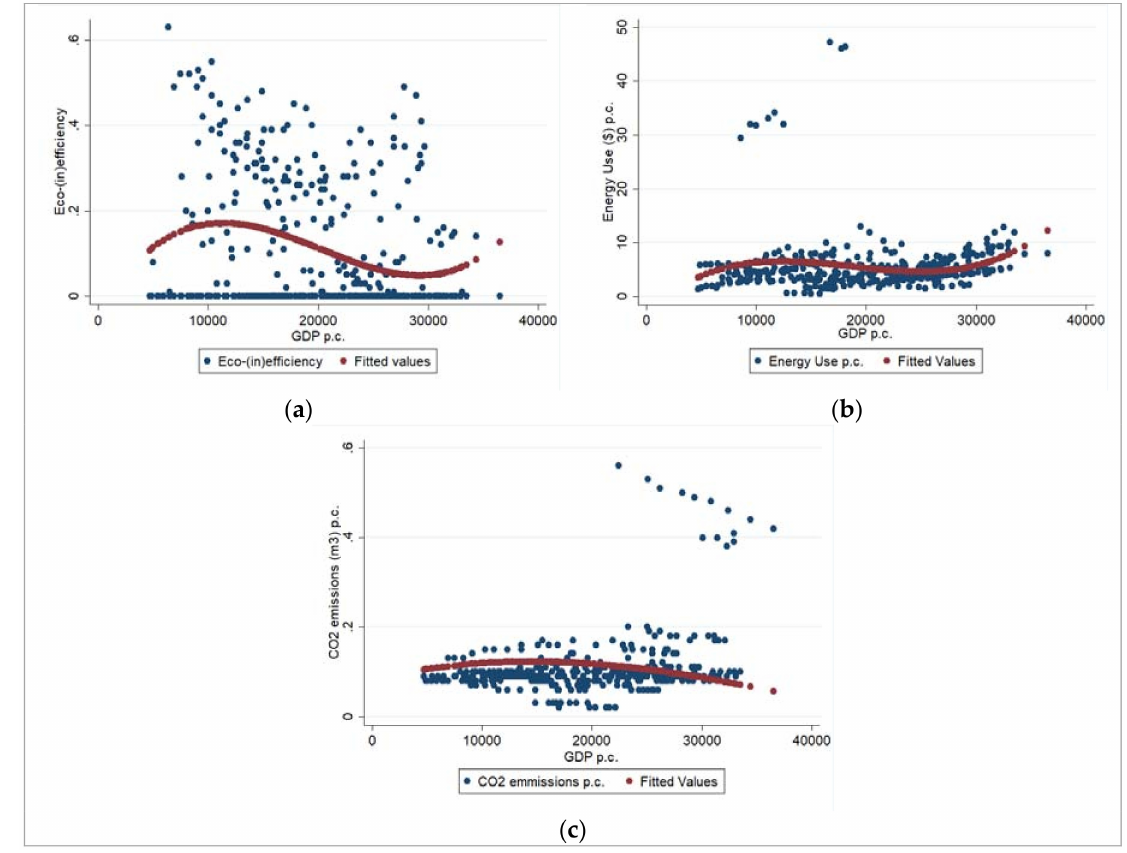
Figure 2. The Turning Points of Models 2.1, 2.2. and 2.3 ( a ) The turning points of Eco-(in)efficiency curve ( b ) The turning points of the energy use curve ( c ) The turning point of the GHG curve (Source: Own